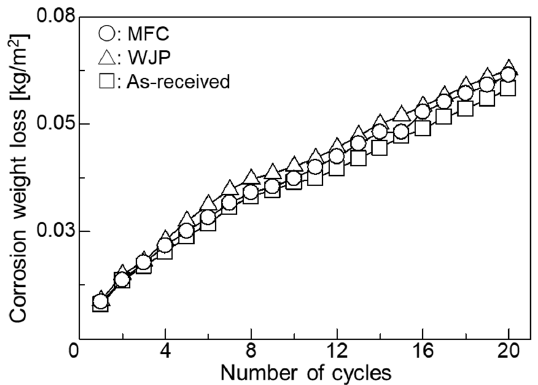
Figure 3. Relationship between corrosion weight loss and number of cycles in embedding test.